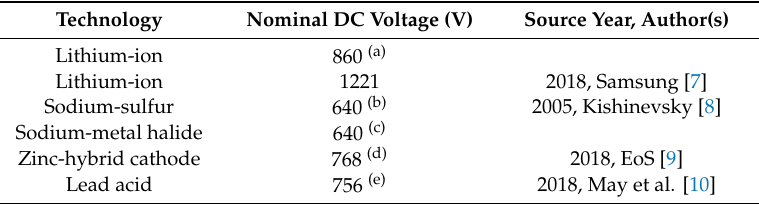
Table 1. System voltages by